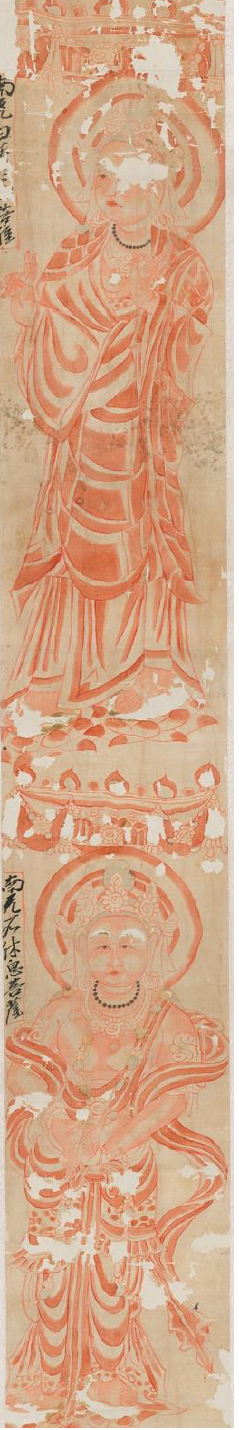
Figure 4. Long Banner of Bodhisattvas , 10th century CE, ink and colors on silk, H. 180.4 cm, W. 28.2